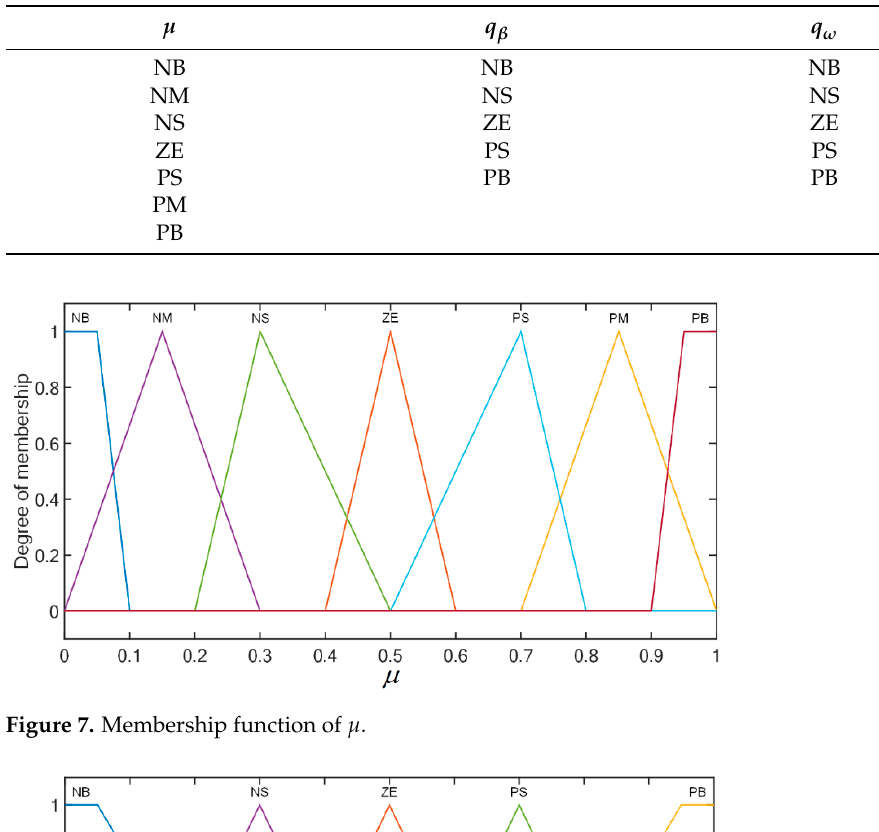
Figure 8. Membership function of 𝑞 (cid:3081) .